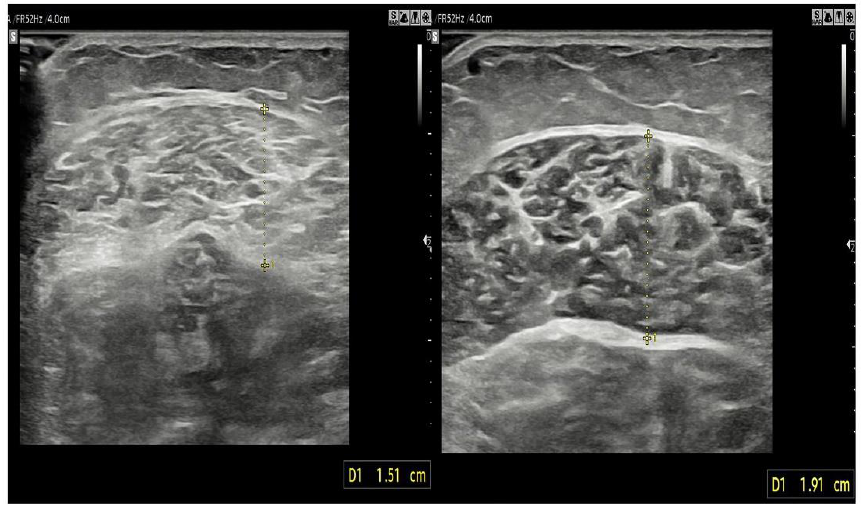
Figure 5. Comparison of thickness of gastrocnemius medialis between faller ( left ) and non-faller ( right ).